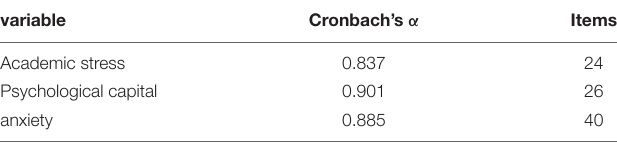
TABLE 1 | Reliability statistics.